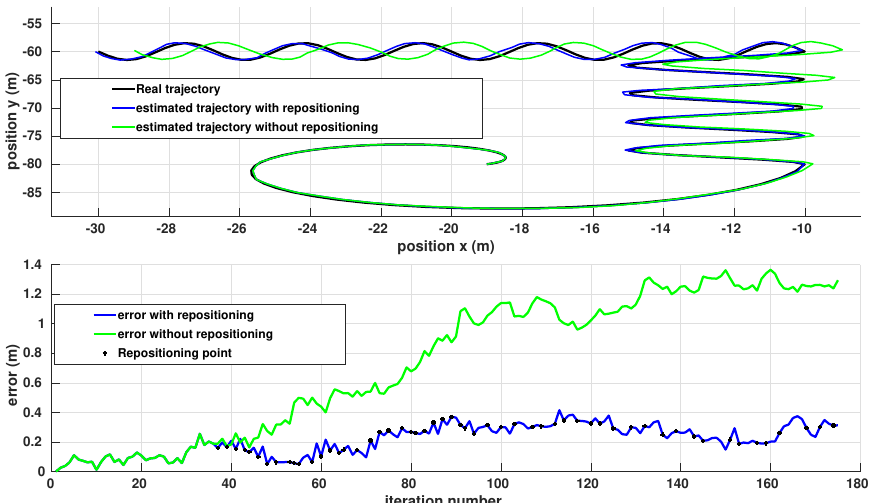
Figure 10. Comparative localization results of one drone of the fleet. ( Top): The trajectories estimated using only inertial odometry ( green curve) and using inertial measurements and distance measure- ments to the anchors located by the drone ( blue curve). The ground truth trajectory is represented by the dark curve. ( Bottom ): The Euclidean error of the localization in each case. Points marked ‘+’ on the blue curve indicate when multilateration is used in the estimation